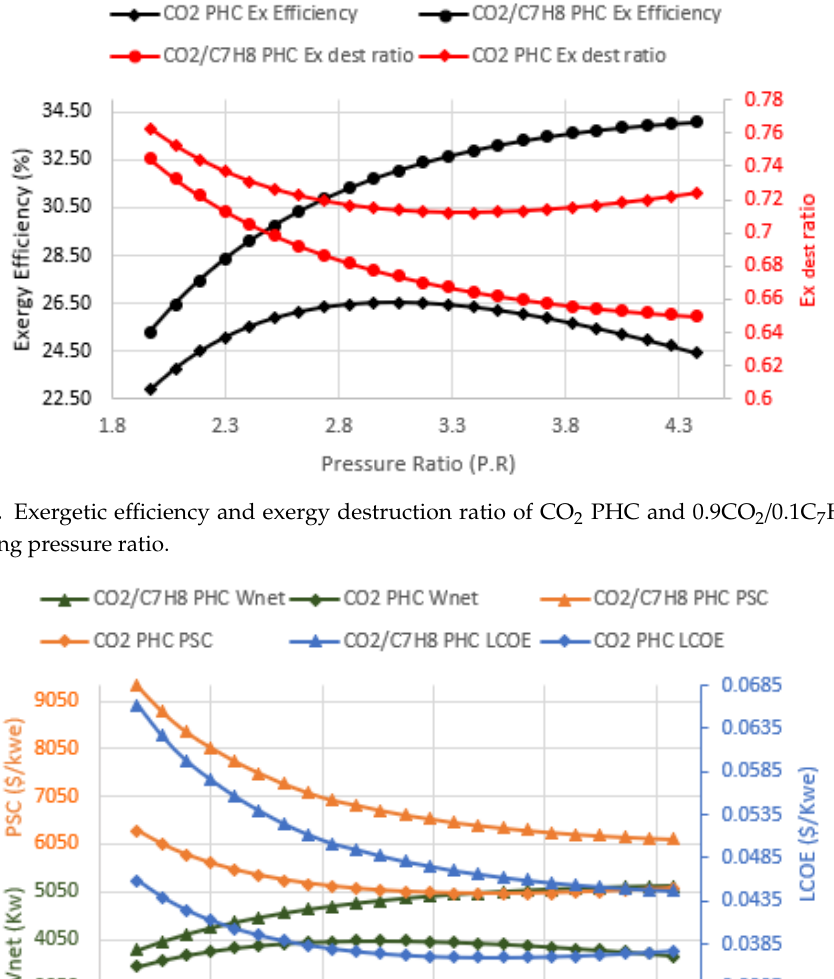
Figure 8. Power output, plant-specific cost and levelized cost of electricity for CO 2 PHC and 0.9CO 2 /0.1C 7 H 8 PHC with respect to pressure ratio.